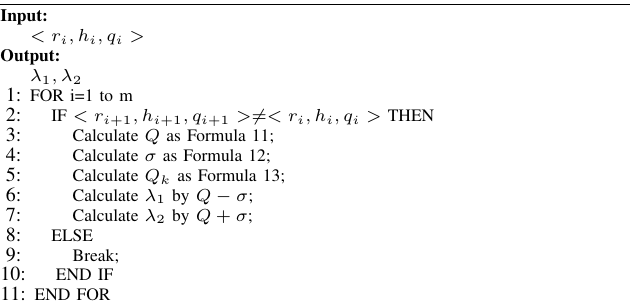
Algorithm 1 Dynamic Self-adaptive Threshold Updating